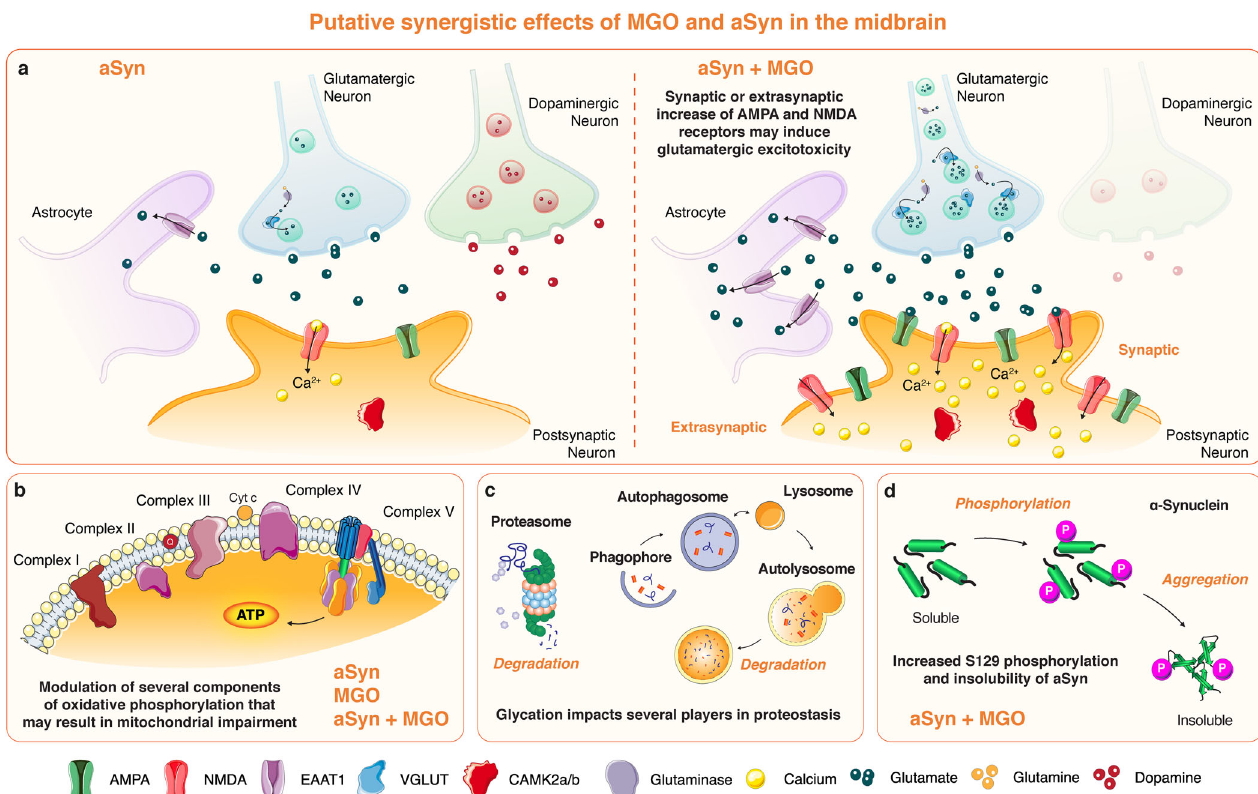
Fig. 10 Putative synergistic effects of MGO and aSyn in the midbrain. a The schematic depicts the MGO-altered glutamatergic proteins in the midbrain of Thy1-aSyn mice. In contrast to control, vehicle-injected mice (left), MGO-injected mice (right) display signs of altered dopaminergic and glutamatergic signaling. Proteomics data suggest a probable increase of glutamate production (glutaminase) and packaging in glutamatergic vesicles (VGLUT), the release of glutamate to the synaptic cleft and astrocytic reuptake (EAAT1) or entry to the postsynaptic neuron via AMPA or NMDA receptors. The increase in these receptors may occur at the synapse or extrasynaptically, inducing excessive calcium entry to the cell. An increase of both CAMK2A and CAMK2B is also observed, supporting the hypothesis of enhanced glutamatergic signaling. A strong imbalance in the postsynaptic levels of calcium can occur and contribute to excitotoxicity. b Proteomics data also suggest alterations in several components of the electron transport chain in the oxidative phosphorylation pathway. Are detected upon aSyn overexpression (Veh-Thy1-aSyn vs Veh-WT mice), after MGO injection (Veh-WT vs MGO-WT) or in MGO-injected Thy1-aSyn (vs Veh-Thy1- aSyn), suggesting that MGO and aSyn trigger the dysfunction of this common pathway. In fact, some of these targets are glycated in MGO- injected Thy1-aSyn mice. c The glycated proteome also impacts on proteostasis components such as the proteasome, autophagy-lysosome pathway, and heat-shock proteins response. d MGO further increases aSyn S129 phosphorylation and aSyn insolubility, typical hallmarks of aSyn